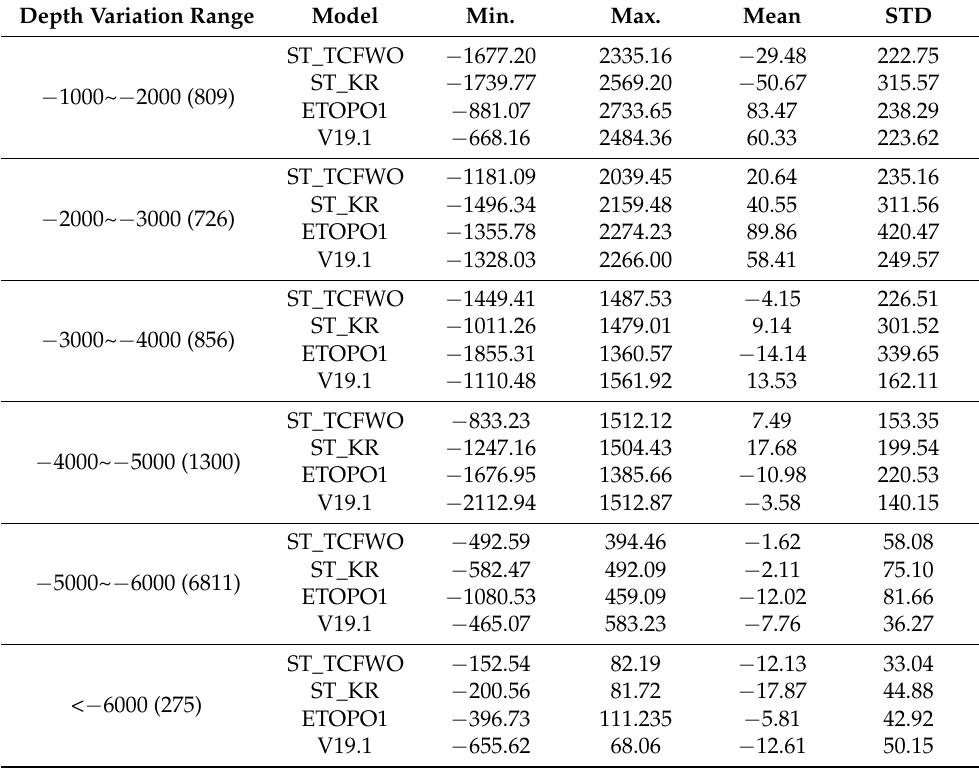
Table 6. Statistical analysis of model checking results with depth variation. (unit: